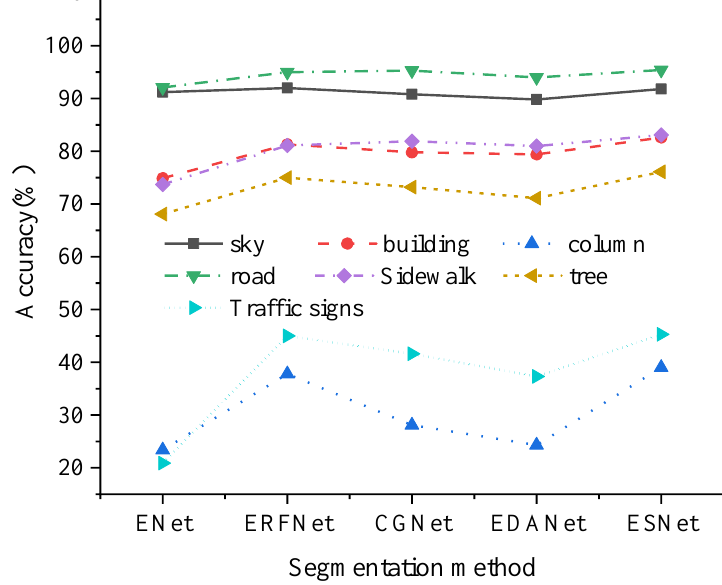
Figure 17. Prediction accuracy of ESNet on various categories.